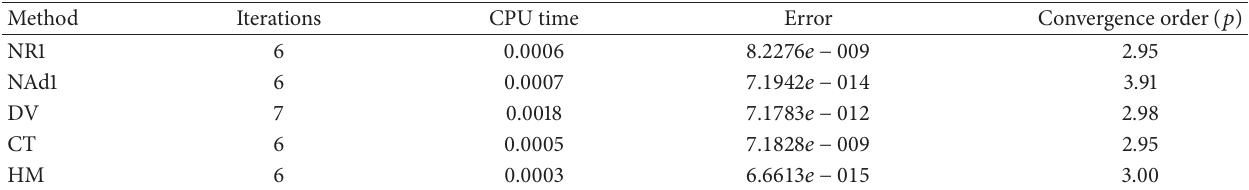
Table 1: Numerical results of Example 1 with initial value 𝑥 0 = 4 .